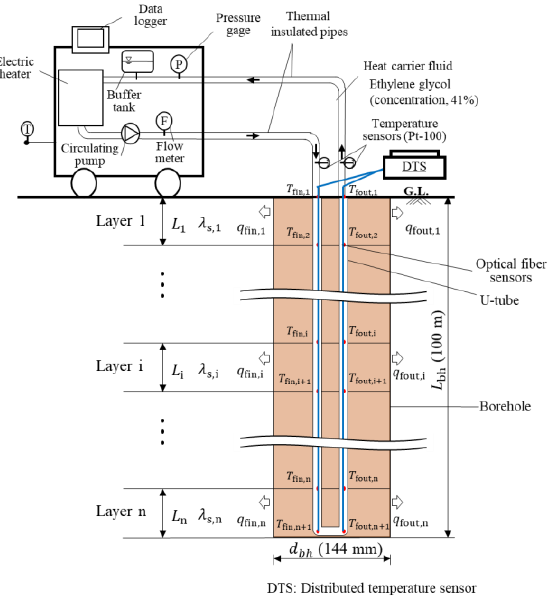
Figure 2. Schematics of the thermal response test (TRT) machine units and the borehole heat exchangers (BHEs).